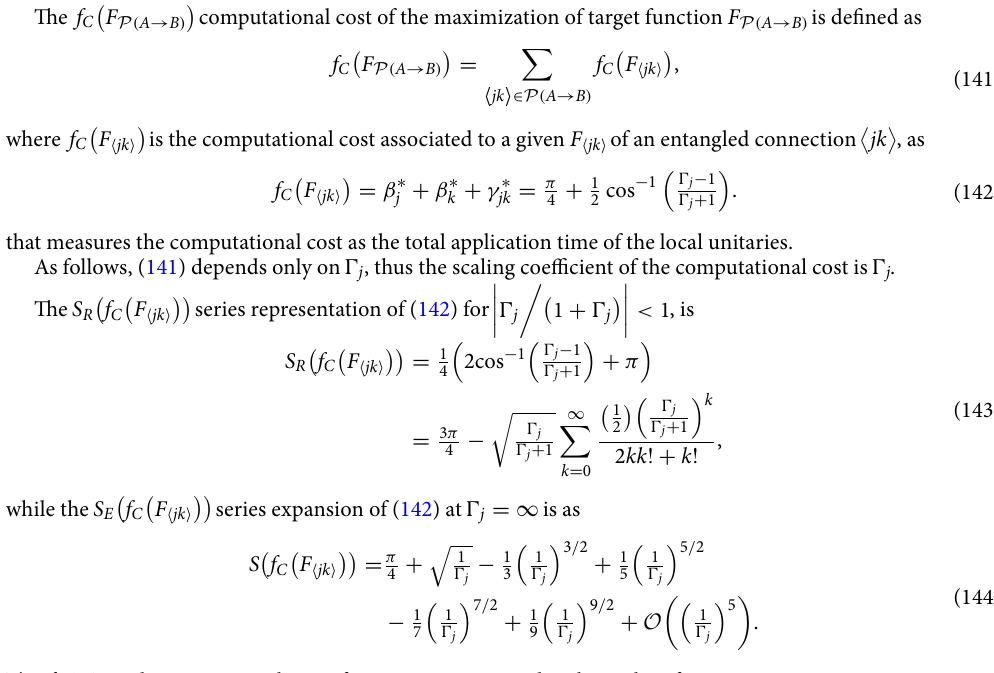
scaled by (a) Ŵ j jk (cid:31) (cid:30)